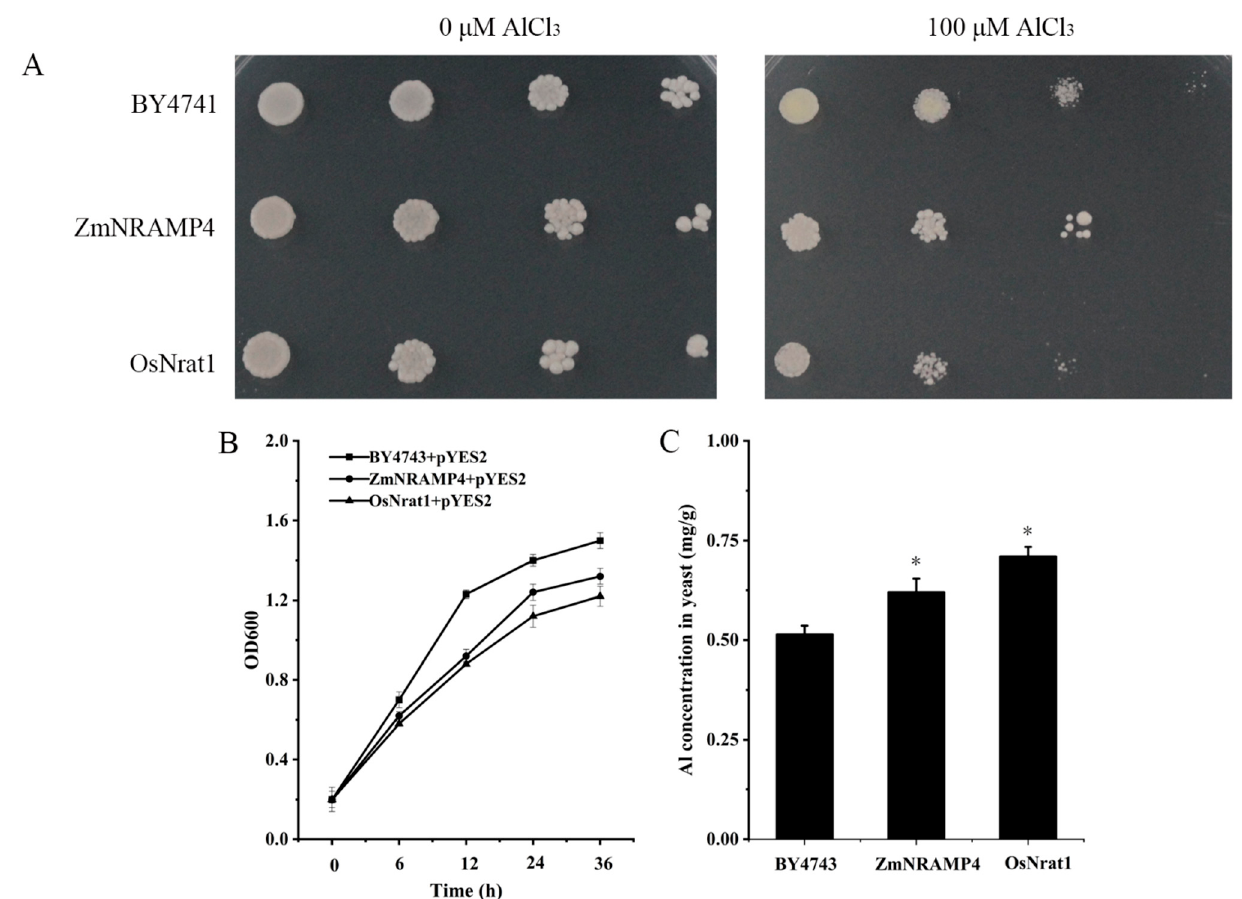
Figure 4. Al transport activity of ZmNRAMP4 in yeast. ( A ), the growth of yeast cells carrying ZmNRAMP4 and OsNrat1 on LPM medium plate with 0 or 100 µM AlCl 3 . ( B ), Growth curves of yeast cells transformed with empty vector pYES2, pYES2- OsNrat1 , or pYES2- ZmNRAMP4 in a galactose containing LPM liquid medium with or without 60 µM AlCl 3 . ( C ), Al concentration in yeast. Asterisk indicated significant difference from control at p < 0.05 by Tukey’s test with three independently biological replicates.